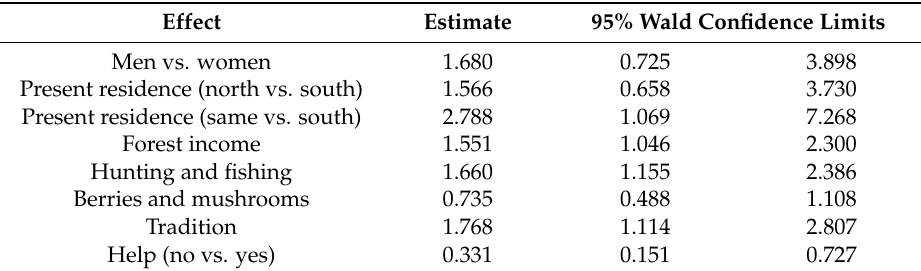
Table 4. Odds ratio estimates for the logistic regression model on the interest to take over.